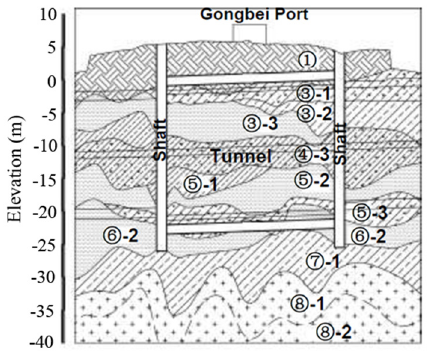
Figure 2 . Geotechnical profile of Gongbei Tunnel.